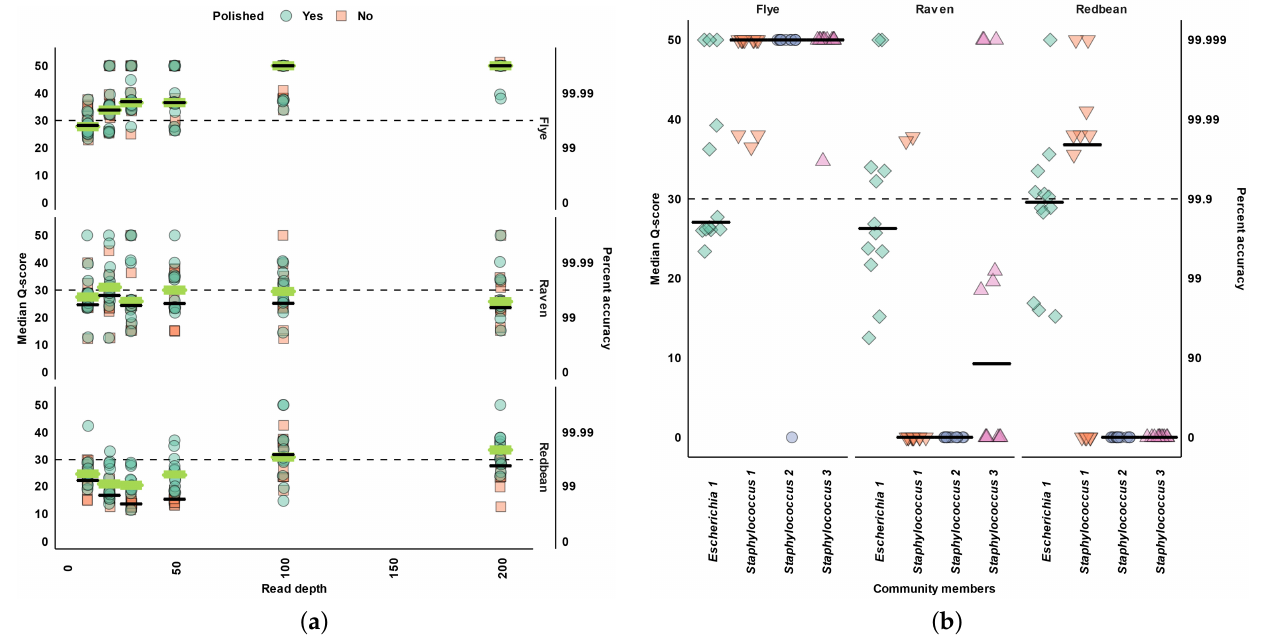
Figure 4. Plasmid accuracy. ( a ) Median Q-score for all replicates at 10 × , 20 × , 30 × , 50 × , 100 × , and 200 × read depth. ( b ) Median Q-score for plasmids at 200 × read depth. Horizontal bars indicate the median. The dashed line indicates the highest Q-score for